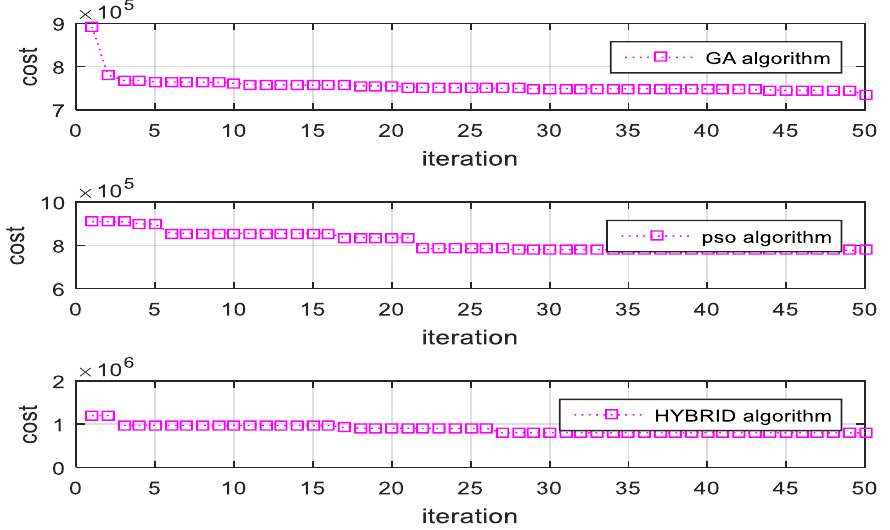
Figure 8. The cost function for GA, PSO, and hybrid optimization technique using MCS based method for scenario-2.